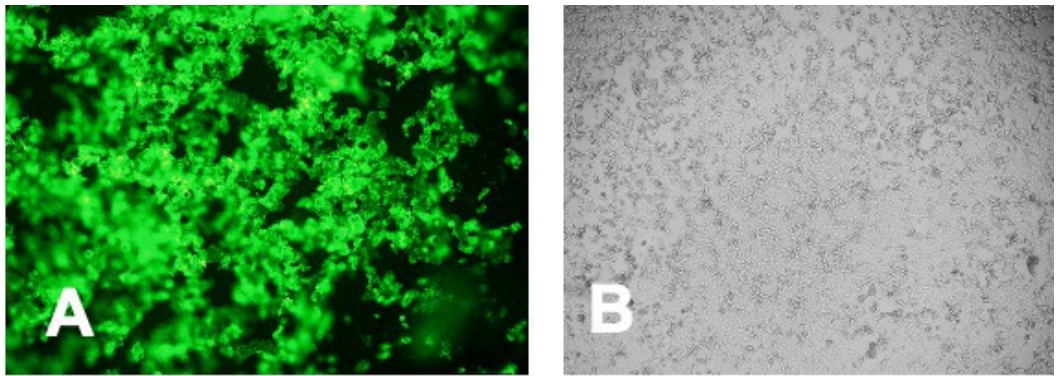
Figure 5. Recognition by anti-S1 IgY antibodies of viral antigen expressed in MERS-CoV-infected Vero E6 cells, using indirect immunofluorescence assay. ( A ) Vero E6 cells inoculated with MERS-CoV and stained with anti-S1 IgY antibodies and FITC-conjugated anti-chicken antibodies; and ( B ) control adjuvant IgY (Bright-field).